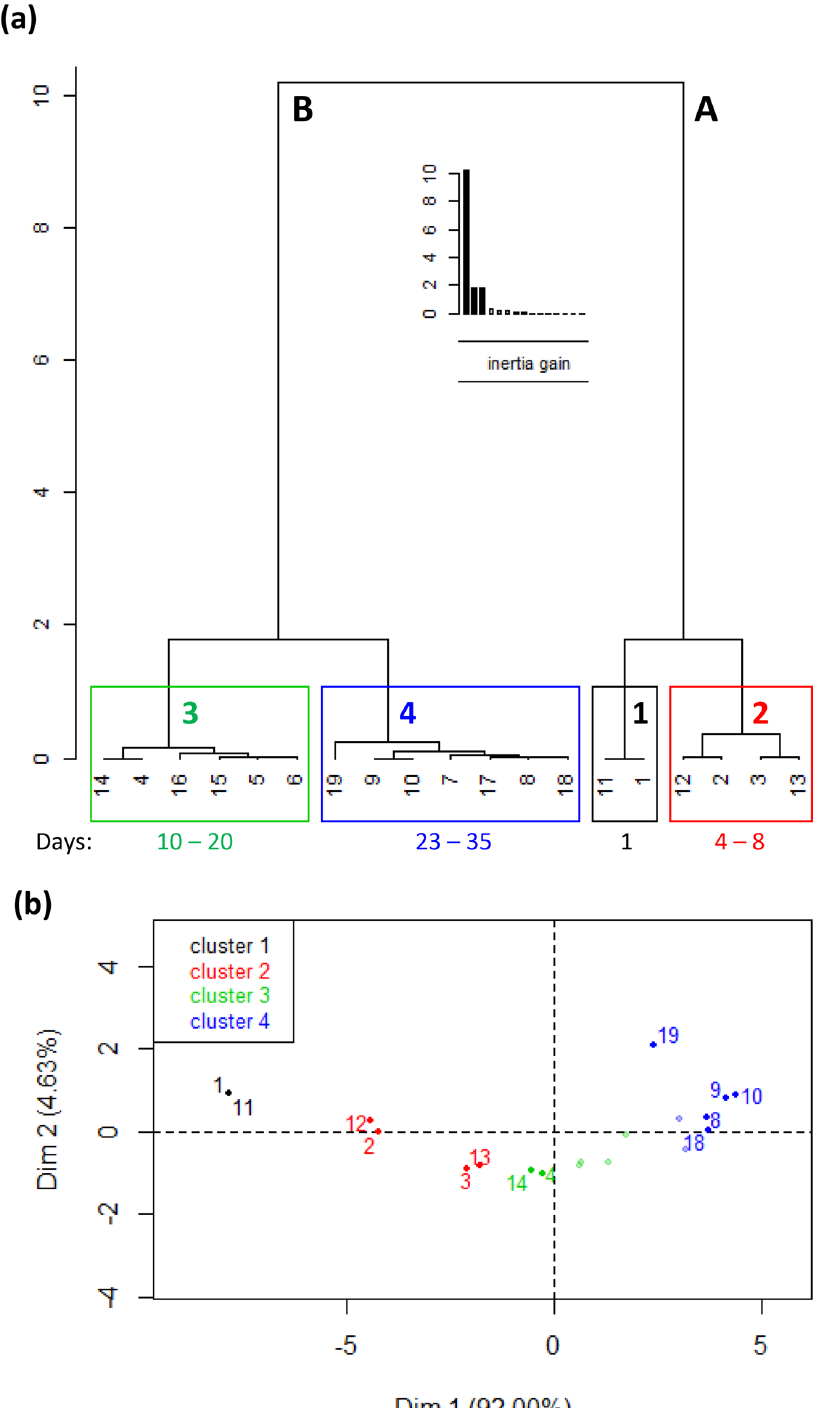
Figure 3. HCPC results showing the coalescing of 19 × 7 multivariate pH and turbidity data into four distinct groupings. ( a ) Dendrogram showing hierarchical similarity of measurements as a function of the length of incubation. ( b ) Scatter plot of scores of the measurements in ( a ) along the most important HCPC dimensions: Dim and Dim 2 (explaining 92.00% and 4.63% of variance, respectively). The natural groupings of scores are labeled or color-coded as cluster 1 (black), cluster 2 (red), cluster 3 (green) and cluster 4